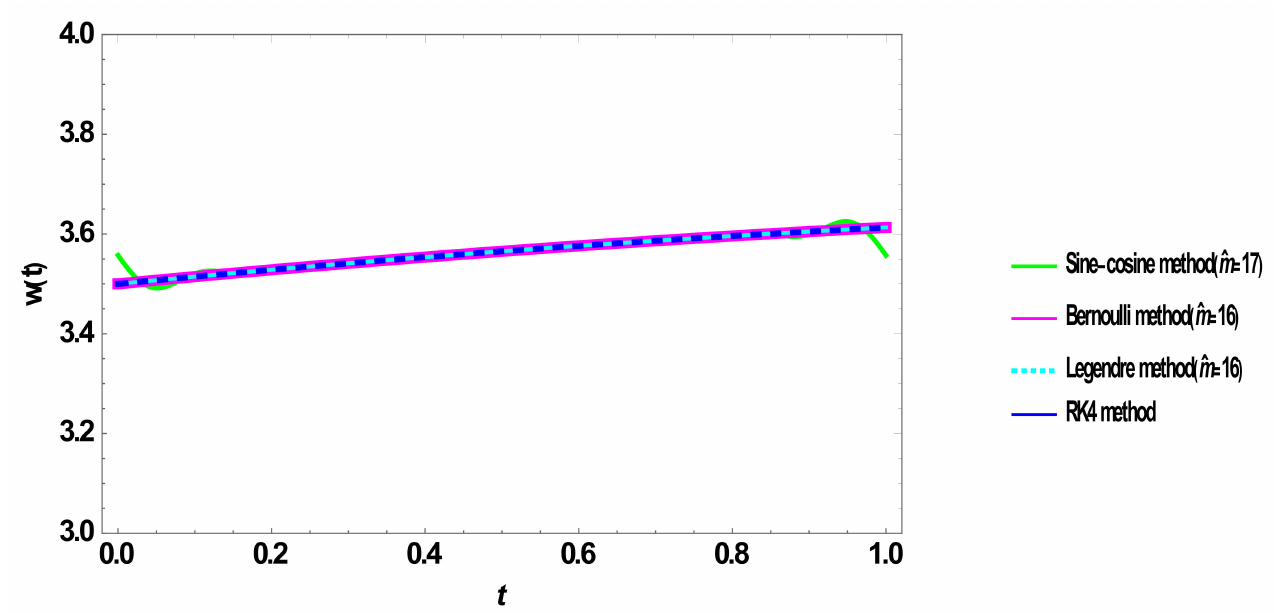
Figure 6. Comparison of the numerical solutions of w ( t ) by using the sine–cosine wavelets method, Bernoulli wavelets method, ALPs and RK4 methods for υ = 1.